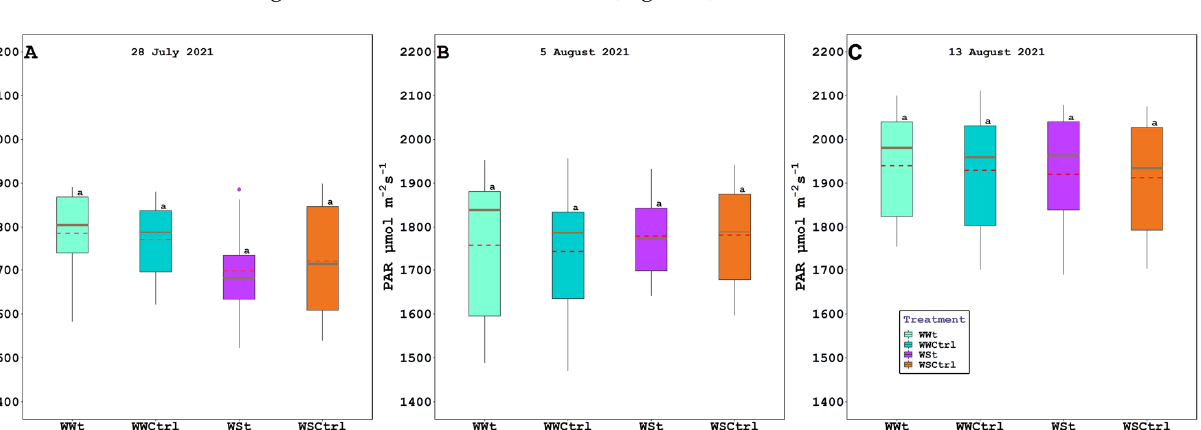
Figure 1. Meteorological parameters of the experiment location. Monthly averages of mean, maxi-